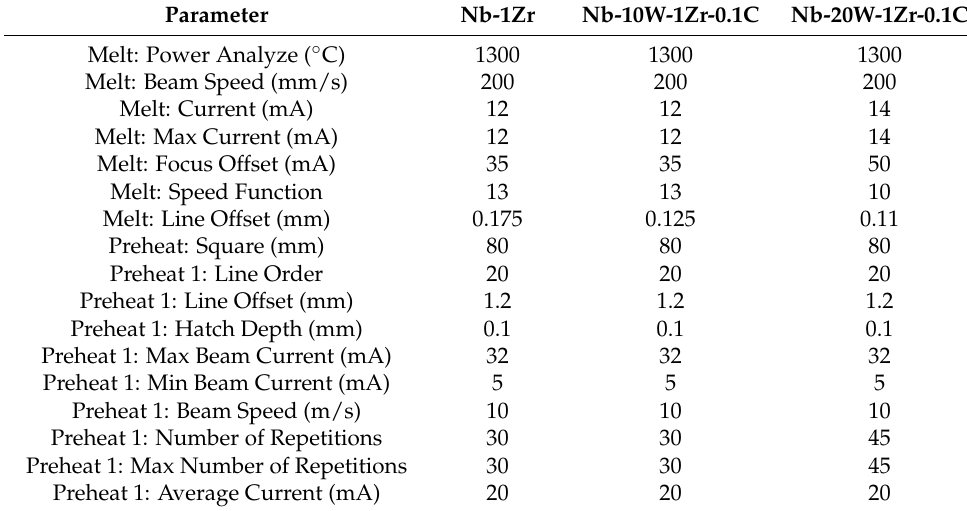
Table 1. EB-PBF parameters specific to the Arcam control system that were used to fabricate the tensile samples in this study (variation from the standard commercial parameter set for Ti6Al4V). Parameter Nb-1Zr